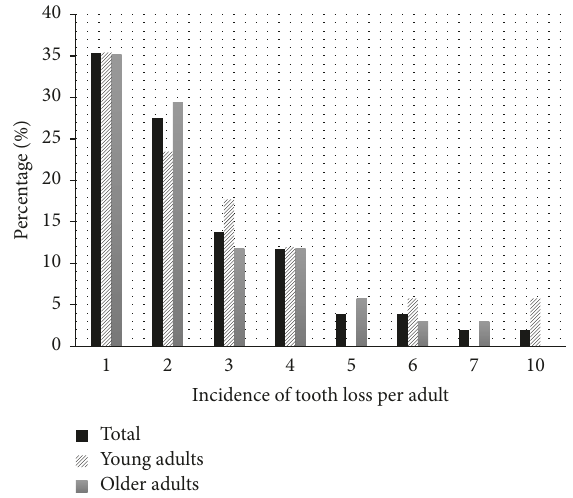
Figure 1: Frequency of total incidence and by age group of the number of teeth lost by adults in the 4-year follow-up. Piracicaba, S˜ao Paulo, Brazil, 2011–2015.